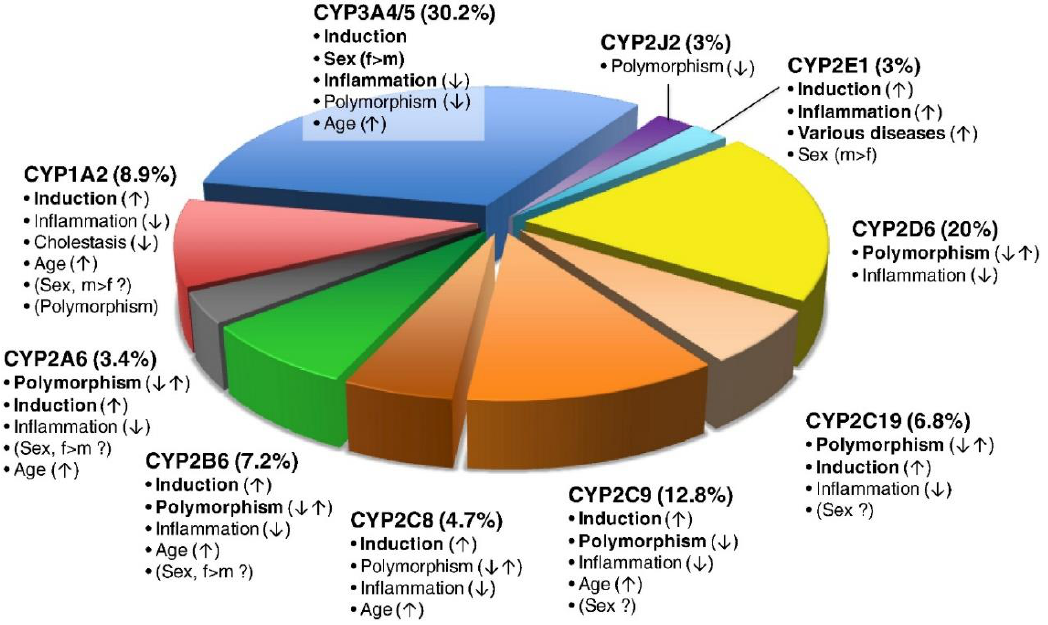
Figure 1. The pie chart depicts the various P450 isoforms, the percentage of clinically used drugs metabolized by the isoform and factors inducing or inhibiting the respective P450 enzyme, thereby influencing variability. The most important factors influencing variability are in bold, with a vertical arrow indicating increased activity ( ↑ ), decreased activity ( ↓ ) or both ( ↑↓ ). Biologic sex (female (f) or male (m)) and rarely polymorphism (CYP1A2) can be of controversial significance. In total, 248